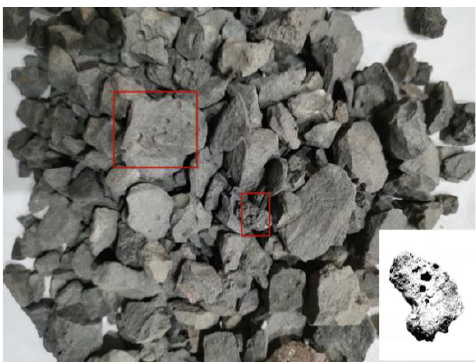
Figure 6. Ferrochrome slag after natural cooling by air. Table 4. Physical performance index of coarse